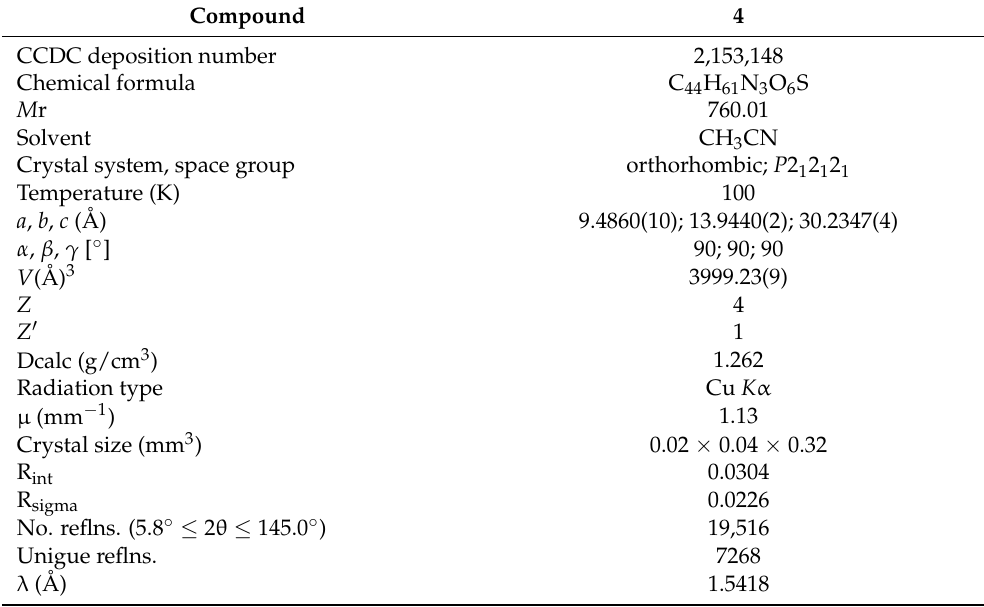
Table 1. Crystal data and structure refinement for 4